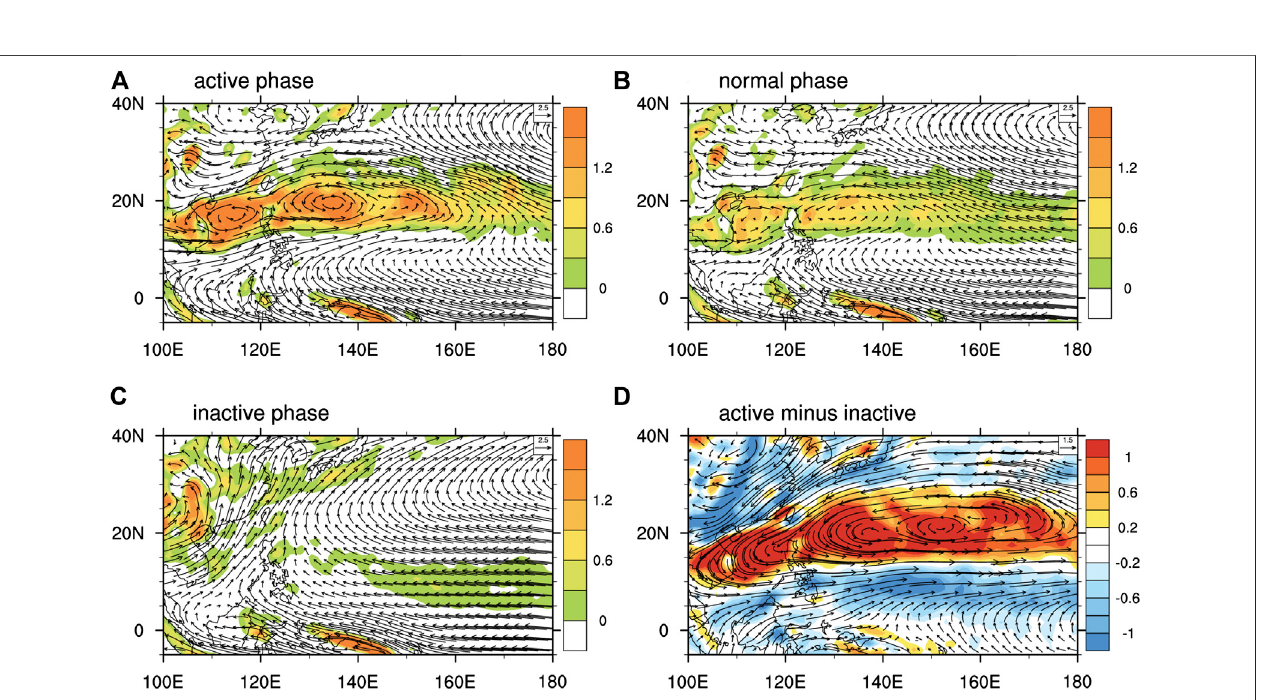
Frontiers in Earth Science |